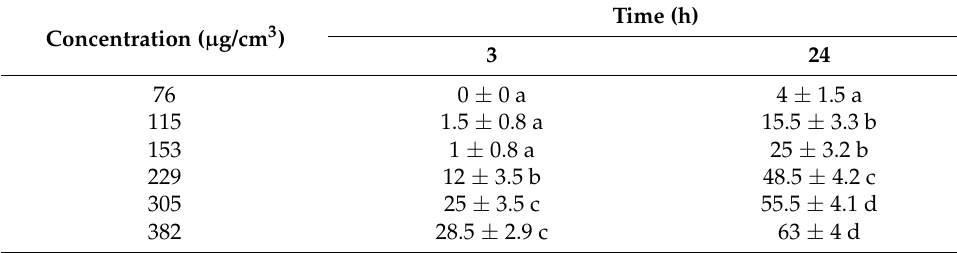
Table 1. Larvicidal activity (%) of PLF He to L. botrana recorded at 3 and 24 h after Petri dish residual exposure bioassay. Means followed by the same letter within each column are not significantly different (Duncan’s multiple range tests [MRT] test p >